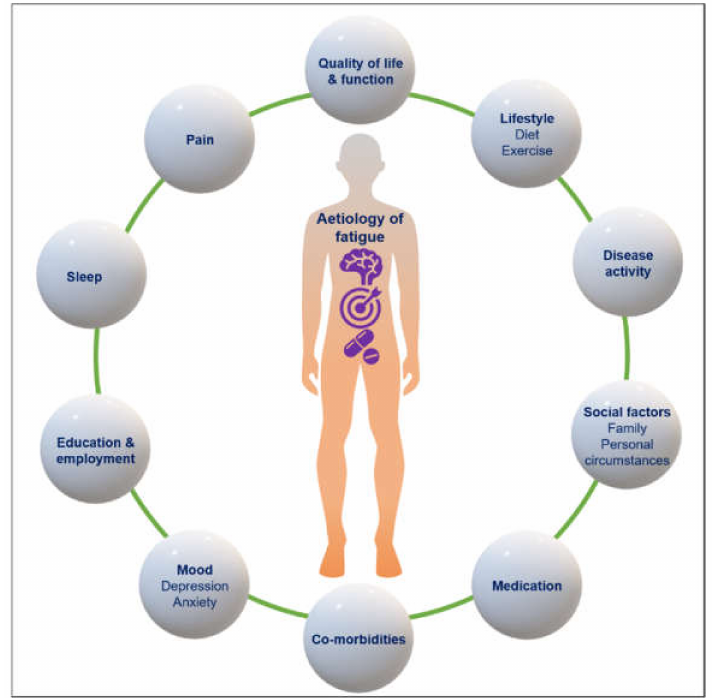
Figure 1. Factors associated with fatigue in rheumatoid arthritis and systemic lupus erythematosus. Fatigue is a complex, multi-factorial symptom. Multiple aspects of a patient’s biological, social and psychological circumstances contribute; this is not an exhaustive list. Examples of broad contributory factors, such as mood, lifestyle and social factors, are provided below each